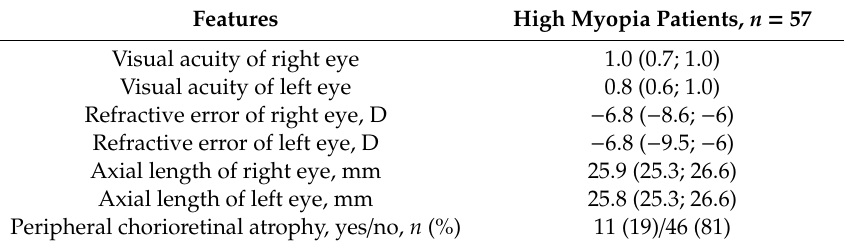
Table 2. Characteristics of clinical parameters of patients with high myopia.